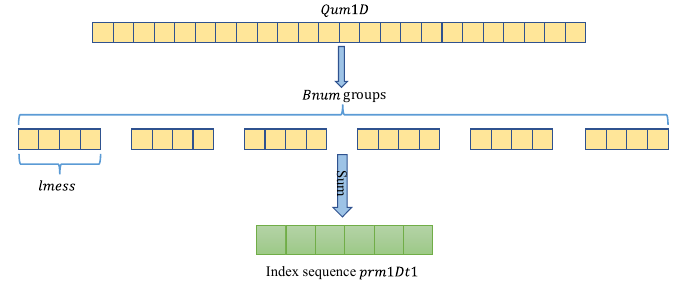
Figure 5. Generation of index sequence 𝑝𝑟𝑚 1 𝐷𝑡 .